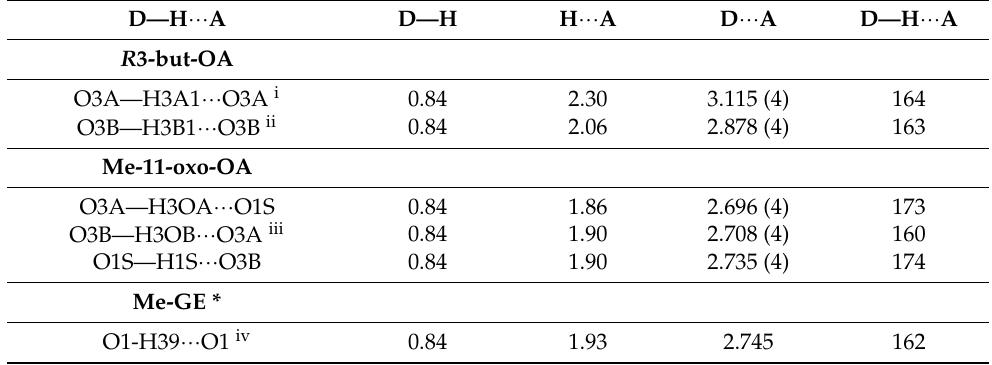
Table 1. Hydrogen-bond geometry (A, ◦ ). Note: Calculated based on: * Beseda